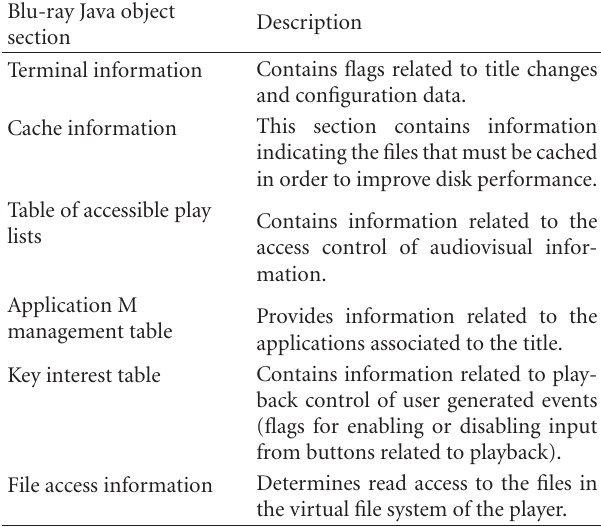
Table 4: Sections of the Blu-ray Java